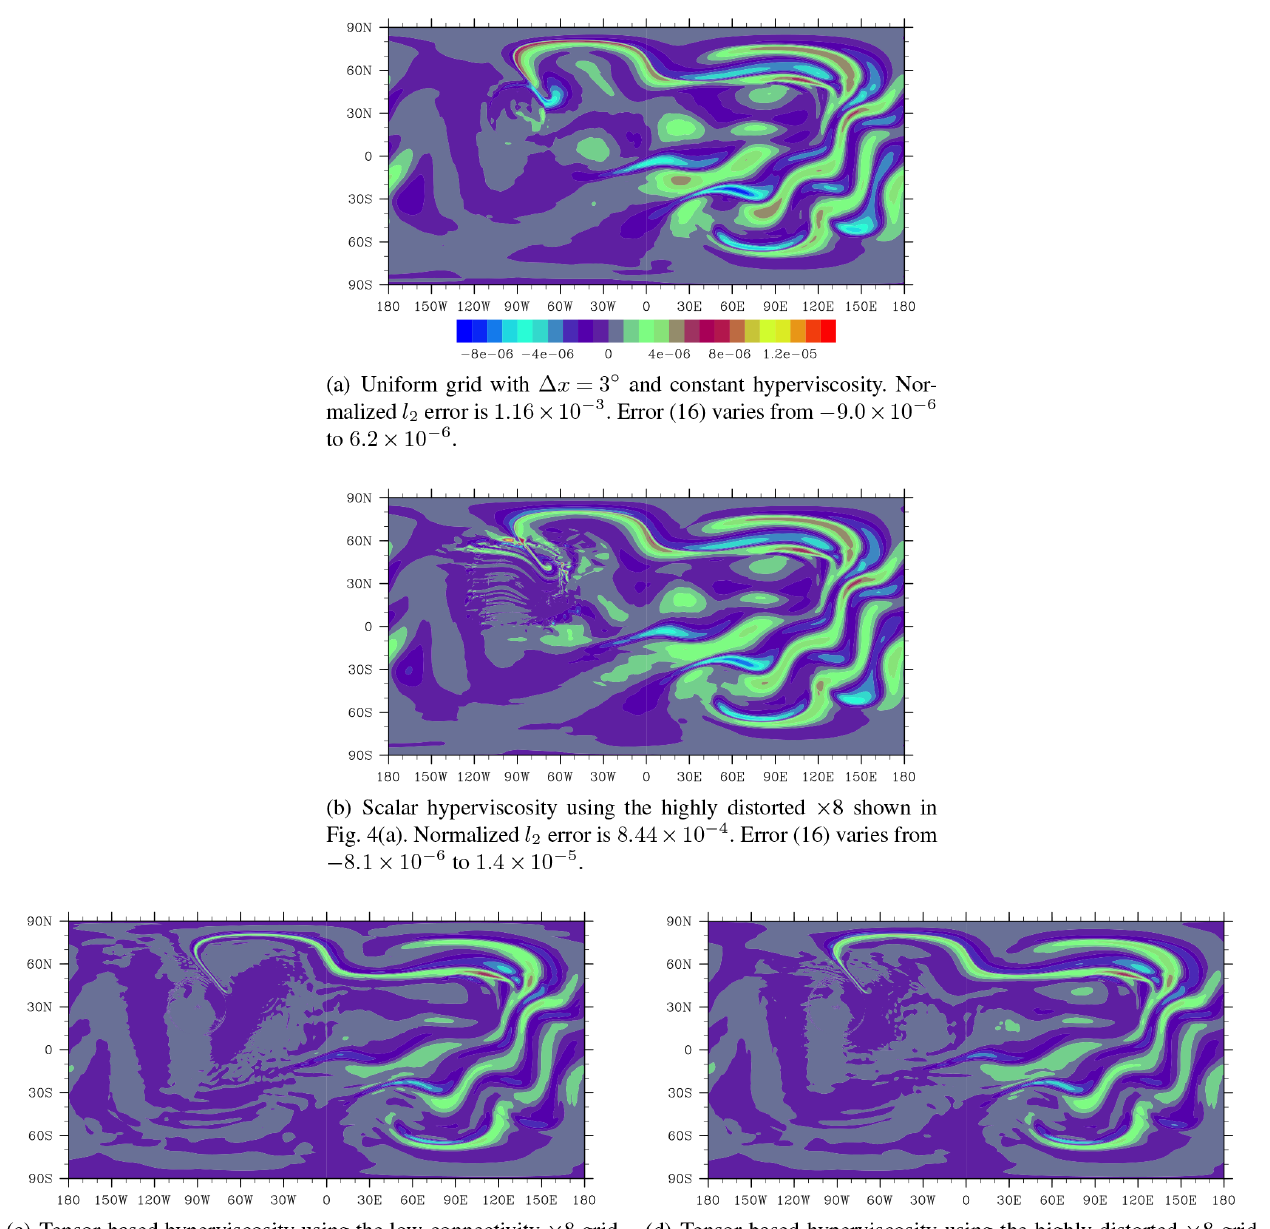
Figure 10. The error in the TC5 vorticity field is plotted for the global domain. The color scheme given in (a) is the same for all plots. The tensor hyperviscosity again produces the best results with very little noise. From comparing panel (c) (tensor hyperviscosity and the low- connectivity grid) and panel (d) (tensor hyperviscosity and the highly distorted grid), we conclude that tensor hyperviscosity is not sensitive to grid